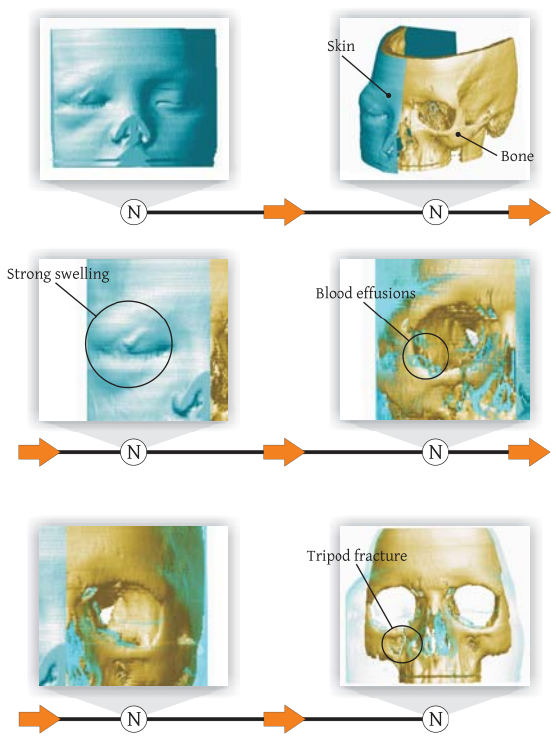
Figure 6. The top two images show an overview of the CT scan data presented by Wohlfart and Hauser. A partial clipping reveals both the skin layer and bone layer, but shows the full set of data. The middle shows a zoomed view that isolates eye swelling in the image ( left ), and a filtered view that exposes some blood effusions in the swollen region. The bottom offers a comparison of the non-injured eye with the injured one and shows the cause of the swelling which is attributed to a tripod fracture just below the eye. This design offers the user a macro overview as to lay the foundations of a story background then narrows the scope to view the focal point of the image [20]. Image courtesy of Wohlfart